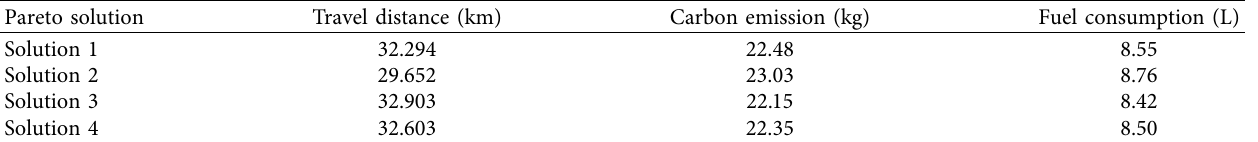
Table 4: Pareto solution target